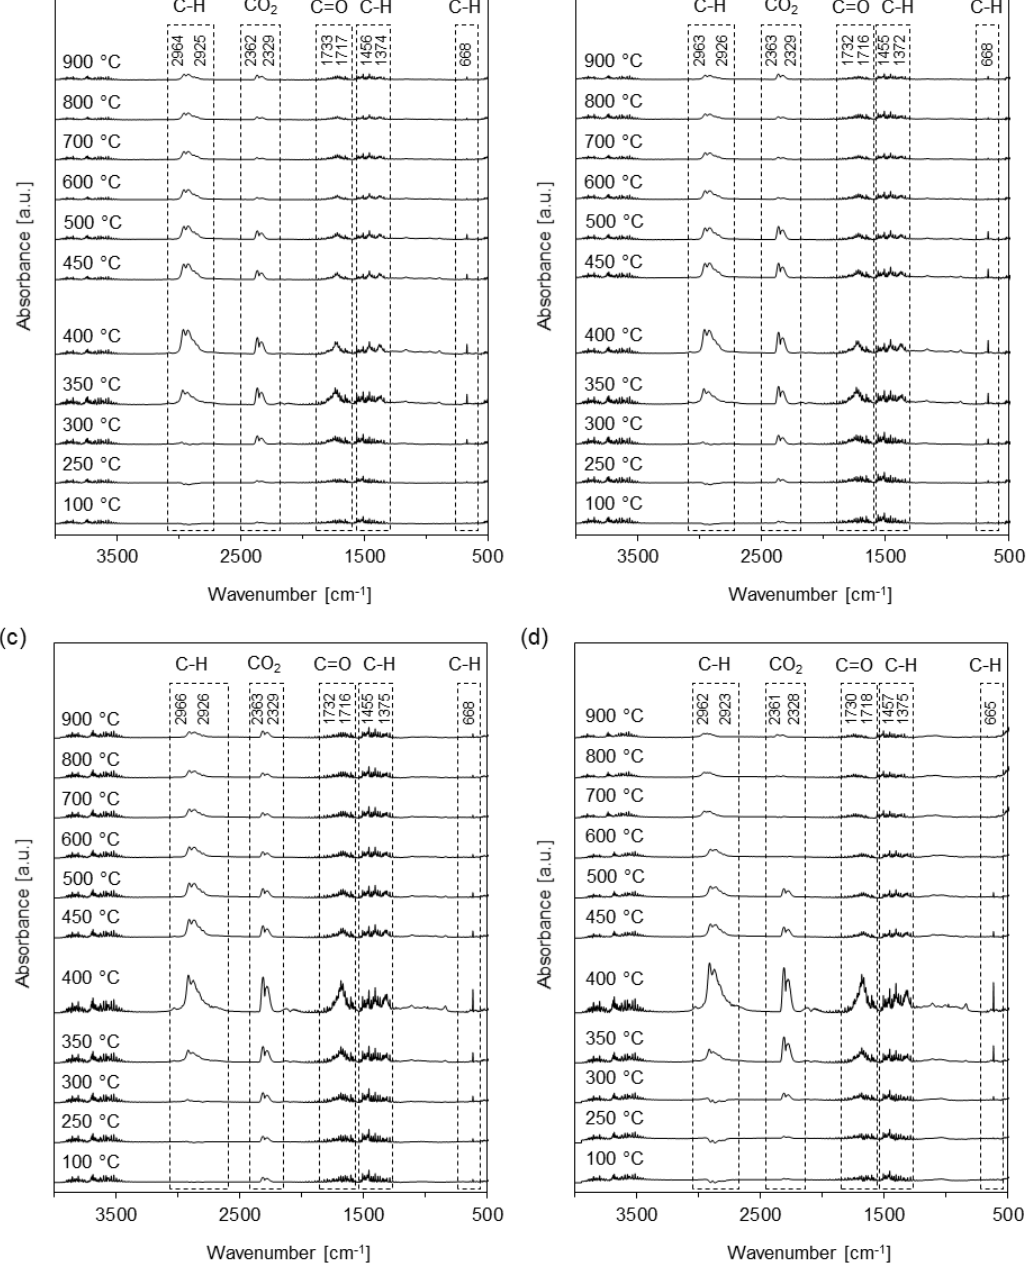
Figure 4. 2D thermogravimetry-Fourier transform infrared spectrometry (TG-FTIR) spectra of pyrolysis products of ( a ) neat PP, ( b ) PP/1%S4SQ-H, ( c ) PP/1%S4SQ-8 and ( d ) PP/1%S4SQ-18 at various temperatures.